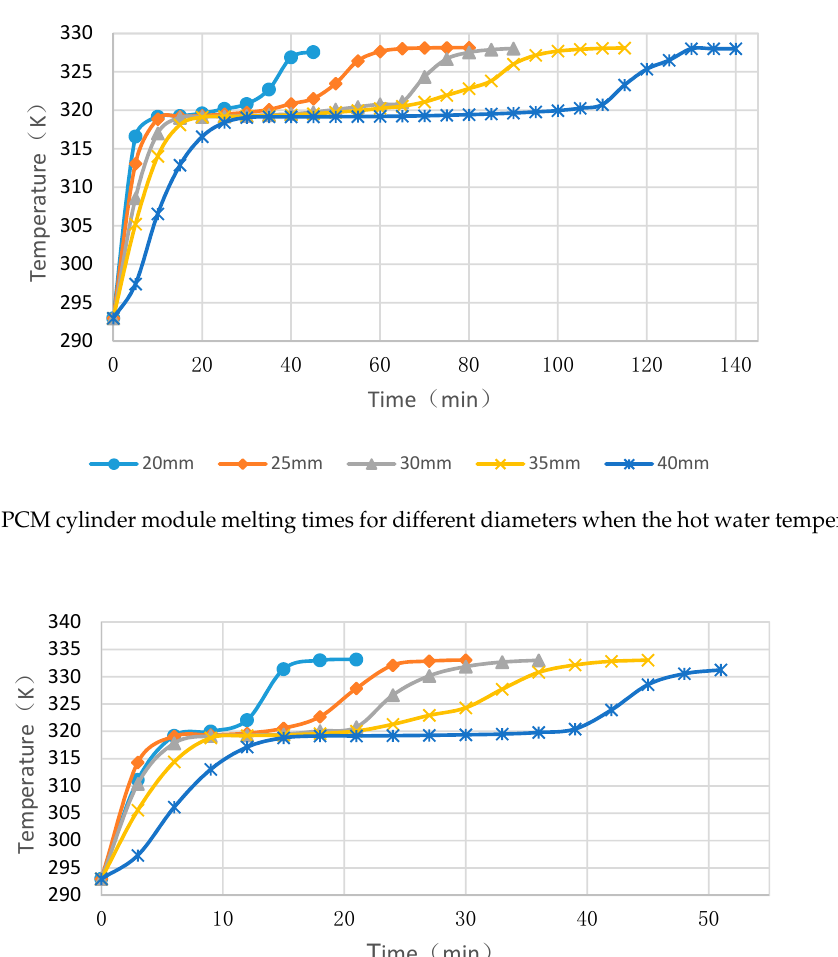
Figure 10. PCM cylinder module melting times for different diameters when the hot water temperature is 50 °C .